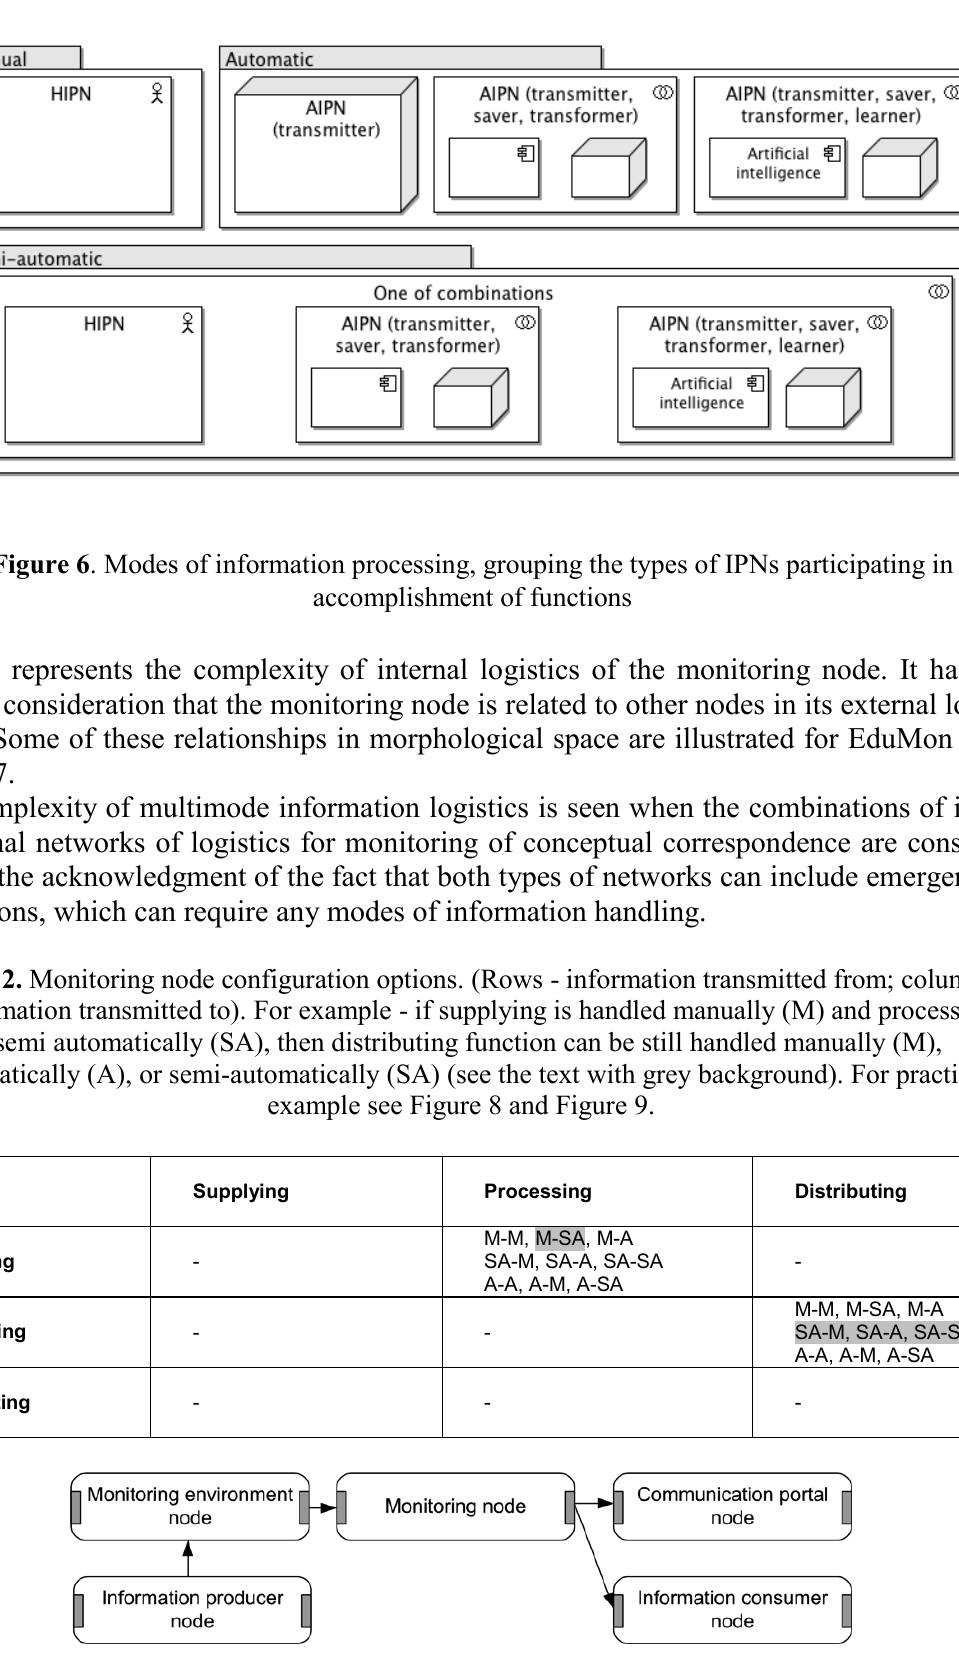
Figure 7. External network of the monitoring node (morphological space of information logistics); it is assumed that the monitoring node in the morphological space includes all IPNs that participate in fulfillment of its functions represented in the functional space of information logistics